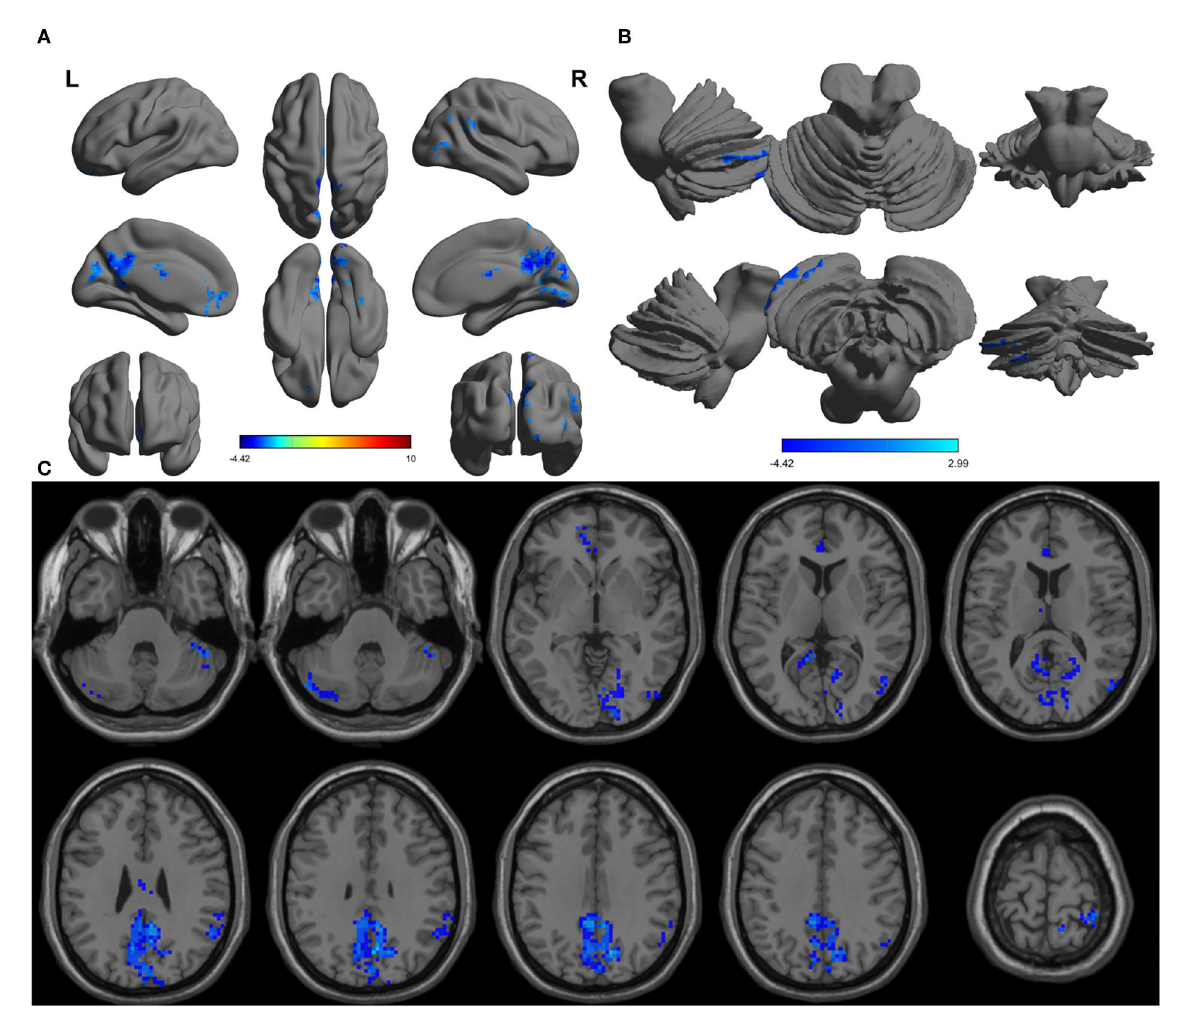
FIGURE2 Altered PerAF in patients with alcohol dependence relative to NCs. (A) Cerebral viewer without cerebellum, (B) cerebral viewer in cerebellum, and (C) axial view with whole brain. Blue color, decreased PerAF areas. R, right; L, left; PerAF, percent amplitude of fluctuation; NCs, normal